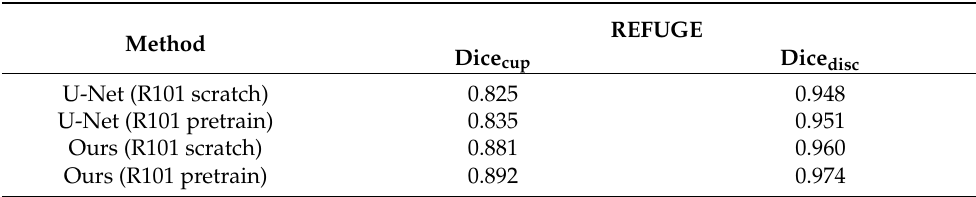
Table 3. Comparisons of our approach (pre-trained weights) compared with the U-net (training from scratch) on the REFUGE